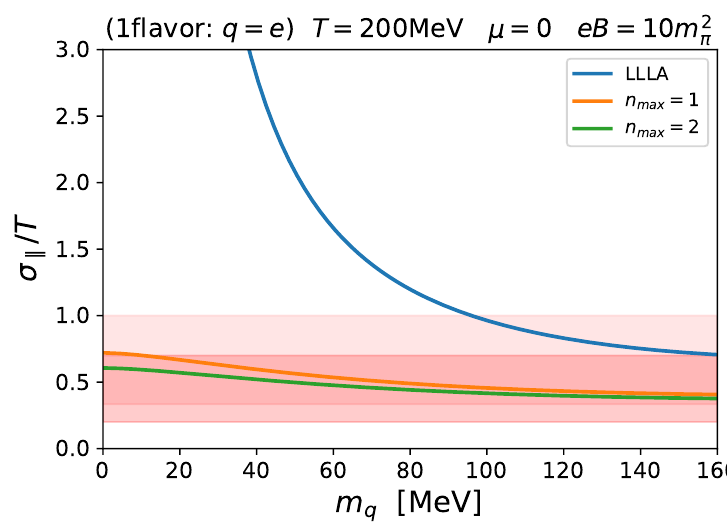
Figure 5 . Mass dependence of the longitudinal electric conductivity for a single (cid:13)avor case with q f = e . In the small mass region the LLLA blows up, while the results at n max = 1 ; 2 have regular behavior at m q 0. The red shaded bands are the lattice-QCD estimates. See the text for (cid:24)